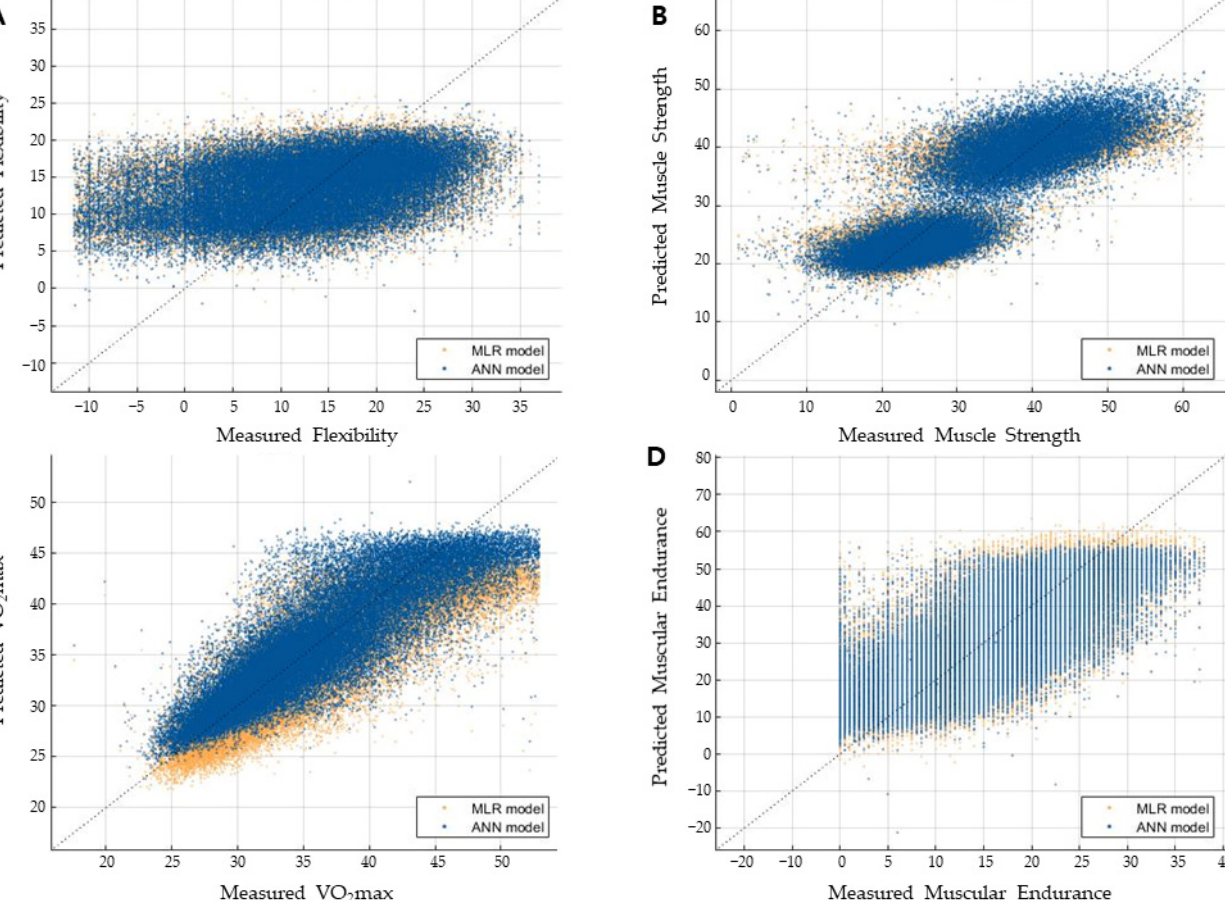
Figure 3. Comparison of scatter plot between the ANN and the MLR estimation model for four HRPF indices. ( A ) Scatter plot for flexibility, ( B ) Scatter plot for muscular strength, ( C ) Scatter plot for VO 2max , ( D ) Scatter plot for muscular endur- ance.